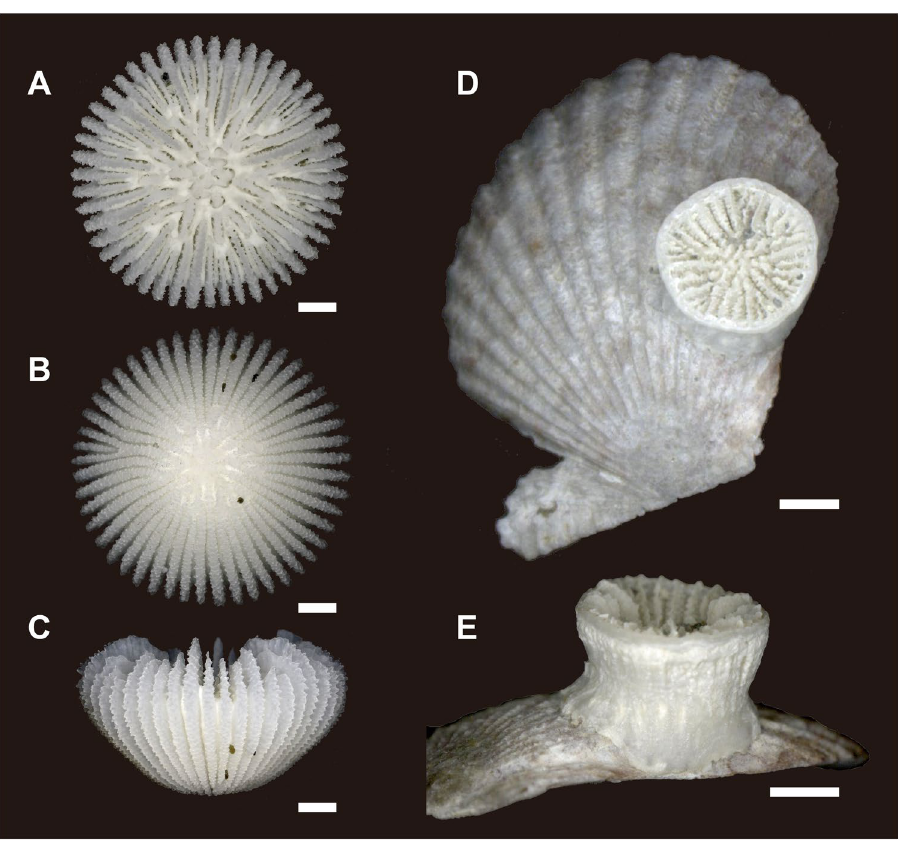
Figure 1. ( A – C ) Oral (top), bottom, and lateral views of Deltocyathoides orientalis . ( D , E ) oral (top) and lateral views of undescribed specie. Scale bars = 1